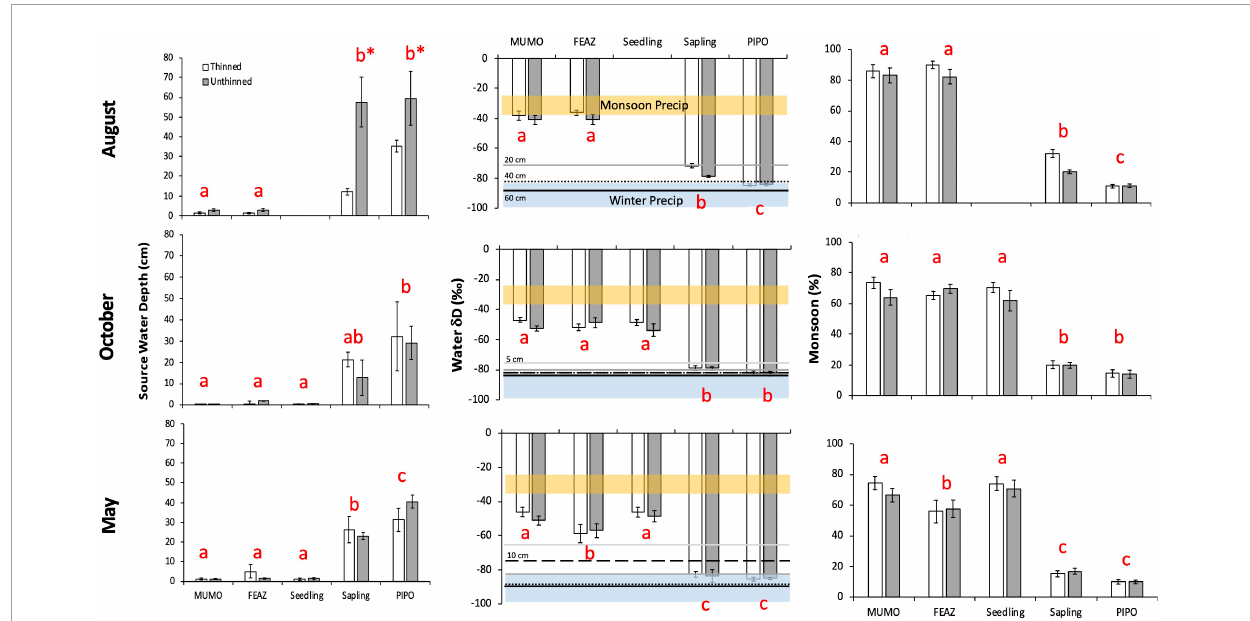
FIGURE2 Mean ( ± SE) source water depth, xylem water δ D, and the monsoon contribution to xylem water at the Fort Valley Experimental Forest near Flagstaff, AZ, USA. Sampling occurred in August 2013 (top row of panels) , October 2013 (middle row of panels) , and May 2014 (bottom row of panels) . Within each panel, asterisks denote a significant difference between thinned and unthinned treatments, and samples not sharing the same letter are significantly different. Samples include: Muhlenbergia montana (MUMO) , Festuca arizonica (FEAZ) , Pinus ponderosa seedlings, P. ponderosa saplings, and P. ponderosa mature trees (PIPO). In the xylem water δ D panels (middle column) , local monsoon (July through September; δ D = –31 ± 6) and winter (October through March; δ D = –91 ± 8) precipitation δ D values are shown in orange and blue bars, respectively (Kerhoulas et al., 2013); mean soil water δ D values are also shown as different horizontal lines for the 5, 10, 20, 40, and 60 cm soil depths (thinned and unthinned stands pooled). Data are missing from seedlings and the 5 and 10 cm soil depths in August due to complications with the cryogenic vacuum extraction